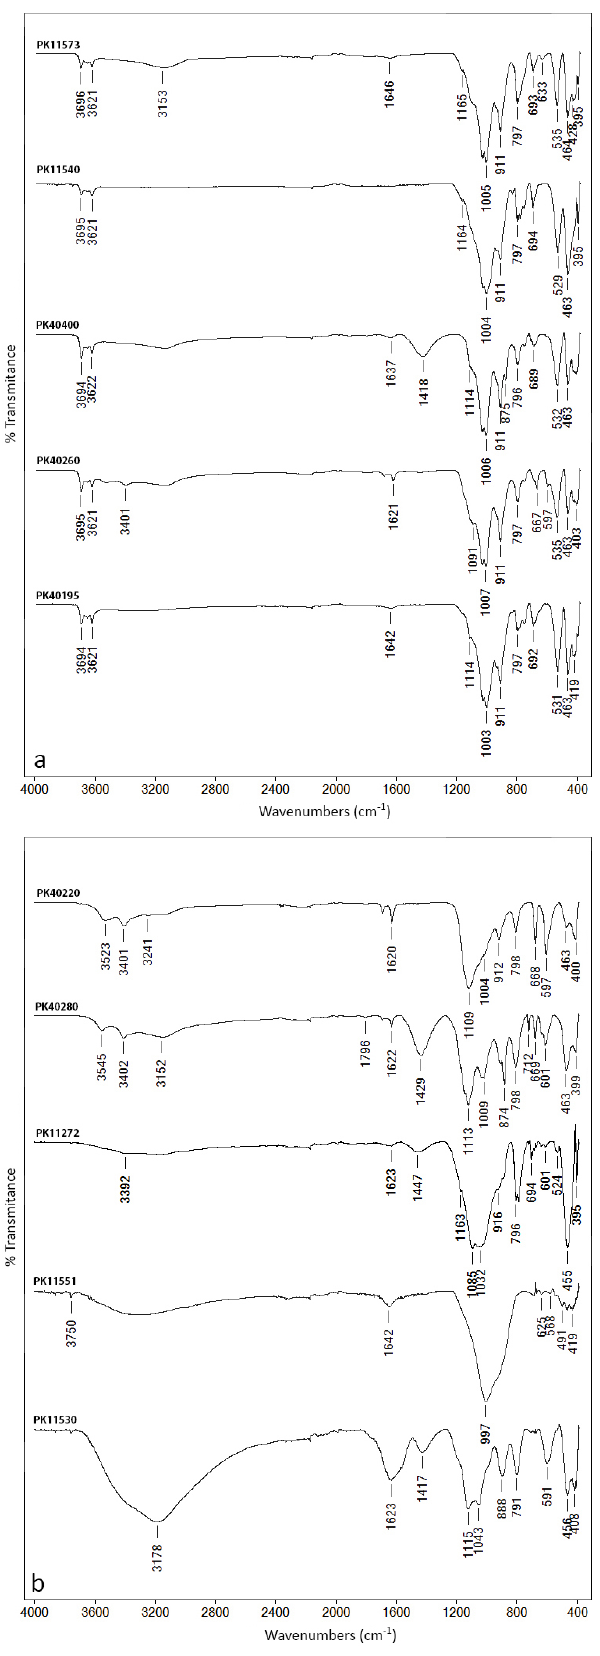
Figure 3. FTIR spectra registered on the yellow ochers: ( a ) ochers rich in kaolinite; ( b ) ochers rich in gypsum—samples PK40220 and PK40280. Goethite ( α -FeO(OH)), the main coloring agent in yellow-brown earths, could be clearly identified in some of the samples via the characteristic hydroxyl stretch at approximately 3150 cm − 1 (broad, poorly defined band) and the hydroxyl deformation bands near 800 and 900 cm − 1 . The lower energy bands in goethite are similar to those in hematite—sharp peaks at c. 530, 460 and 400 cm − 1 ascribed to lattice vibrations [13,65]. For samples PK11272 and PK11573, a lattice band around 630 cm − 1 can also be observed. As discussed in previous studies [10,65,66], sev- eral factors can affect the position of the goethite bands—including particle size, crystallinity, adsorbed water or the isomorphous substitution of iron by aluminum. The presence of sili- cates (especially quartz) and other clay minerals, even in low amounts, can also affect the iden- tification of goethite, given the similar region of absorption [67]. Moreover, in situations when the hydroxyl stretch is partially obscured by the presence of water, a clear identification of goethite is less likely to be found using FTIR analysis alone. However, for such situations, the presence of goethite can be clearly confirmed with Raman analysis (Figure 2c,d) via the char- acteristic doublet observed at approx. 300 and 390 cm − 1 [41].